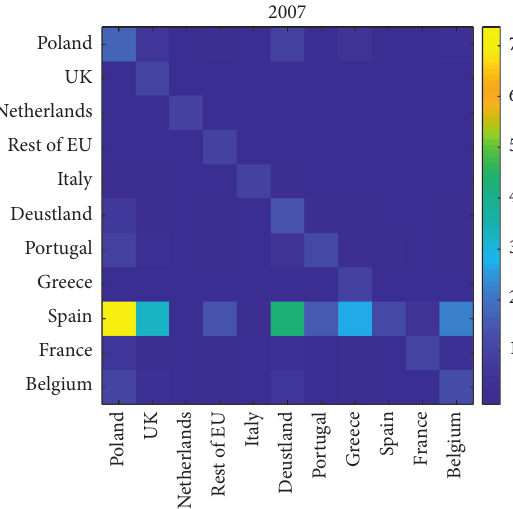
Figure 2: Triangulation of inverse matrix 2002. Source: own compilation.